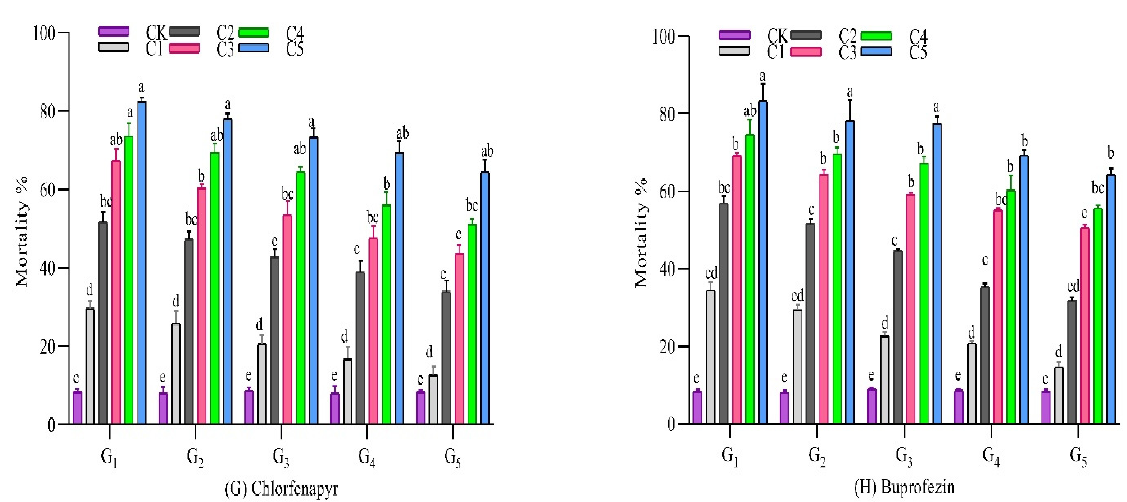
Figure 1. Mortality percentage of B. tabaci to five concentrations of eight different insecticides ( A – H ), at five generations. (G = generation, C = concentration, CK = control). Means followed by the same letter (a–e) above vertical bars are not significantly different at 5% level of